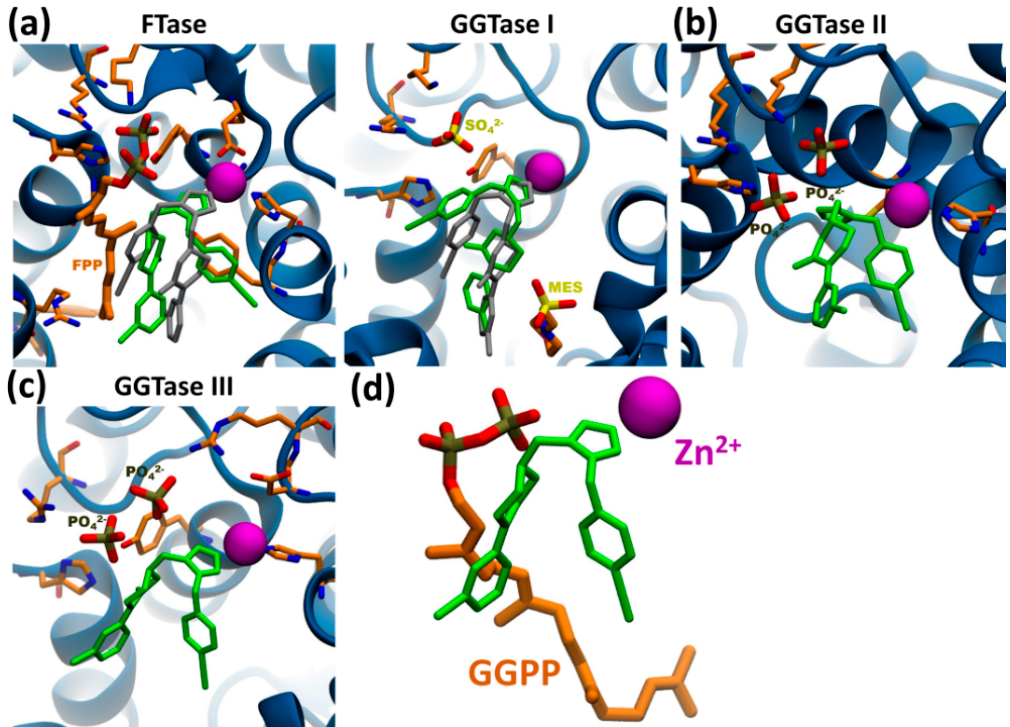
Figure 6. Docking of L-778,123 to prenyl-transferase active sites. ( a ) Docking of L-778,123 to crystal structures of FTase (left, PDB: 1S63) and GGTase I (right, PDB: 1S64). The preferred conformations of the drug in green are consistent with the superimposed crystallized conformation in grey. L-778,123 inhibitory activity requires chelation of the catalytic zinc ion (purple) through coordination of the imidazole ring. Important amino acid side chains in orange. ( b ) A preferred conformation for L-778,123 docking to GGTase II (PDB: 3DSS with superimposed two PO 43- ions) is possible in presence of anions in the pyrophosphate pocket (see Figure S20B) and does not coordinate with the catalytic zinc ion. ( c ) L-778,123 docks to GGTase III (PDB: 6J74) co-crystalized with anions in the pyrophosphate pocket (see Figure S20C), with the imidazole group coordinating with the catalytic zinc ion, similarly to known targets FTase and GGTase I in ( a ). ( d ) Superimposition of docked L-778,123 structure from ( c ) with GGPP within GGTase III (PDB: 6J7X) shows the probable mechanism of inhibition by occupying the isoprenoid pocket in the active site.